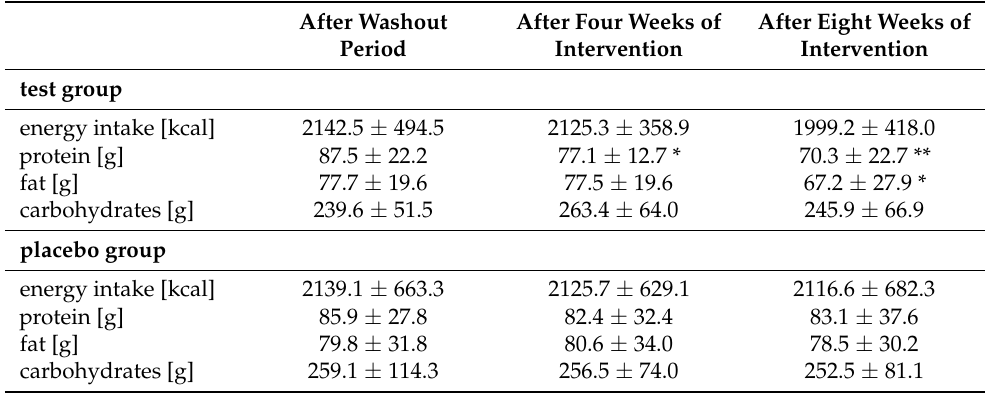
Table 2. The average daily energy and nutrient intakes of volunteers calculated with PRODI 5 Expert software, based on seven-day food records completed in the one week of the washout period, four and eight weeks of intervention. Data are presented as means and standard deviation (SD); significant differences in comparison to the washout period: * p < 0.05; ** p < 0.01.